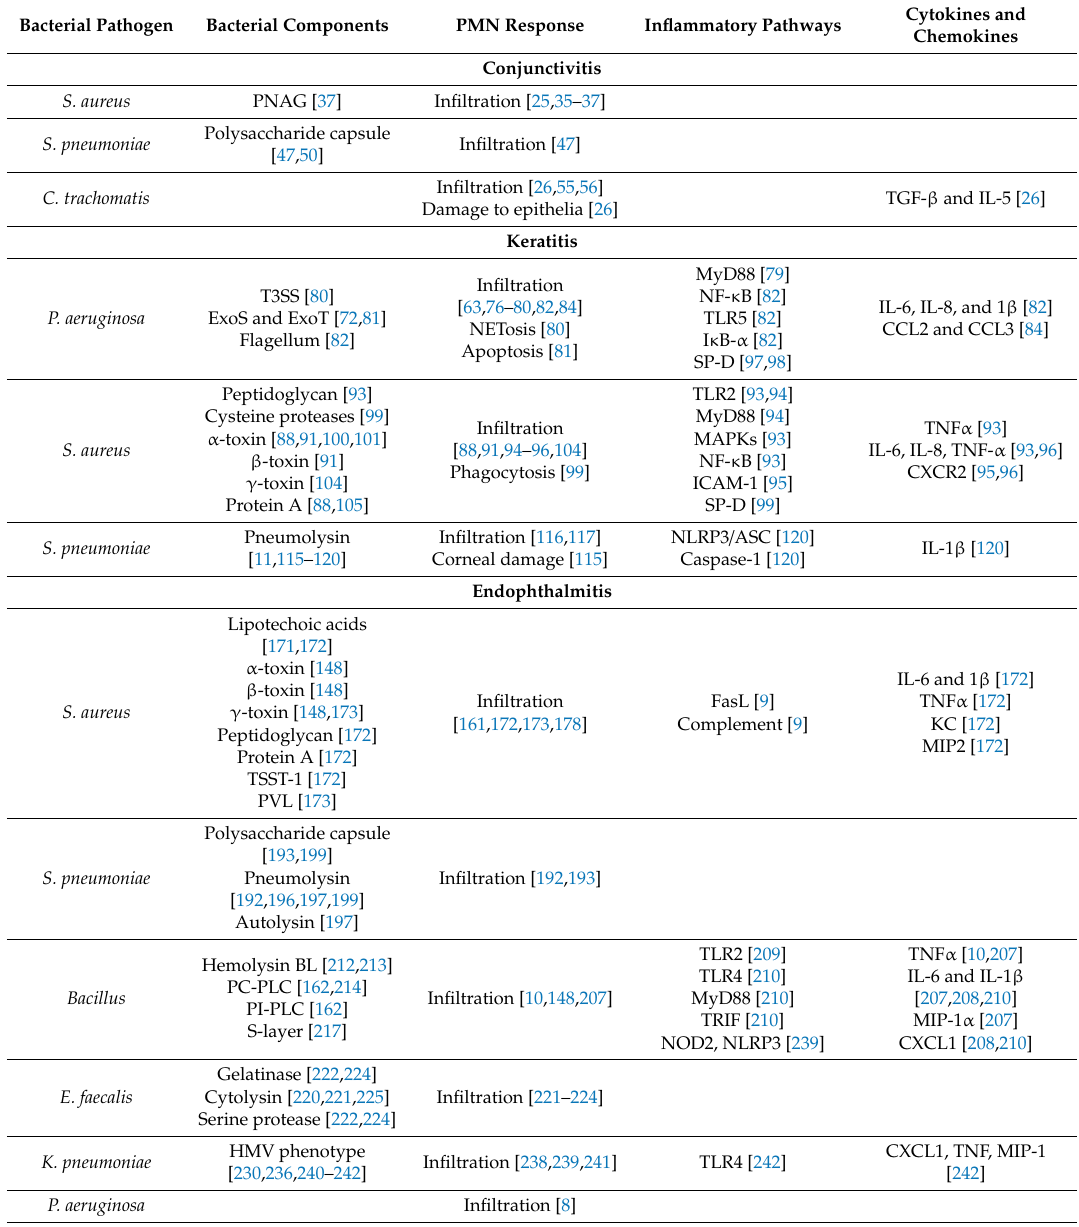
Table 1. Summary of bacterial components, PMN responses, and inflammatory pathways and cytokines involved in bacterial ocular infections. MyD88: myeloid di ff erentiation primary response 88, SP-D: surfactant protein D, TLR: Toll-like